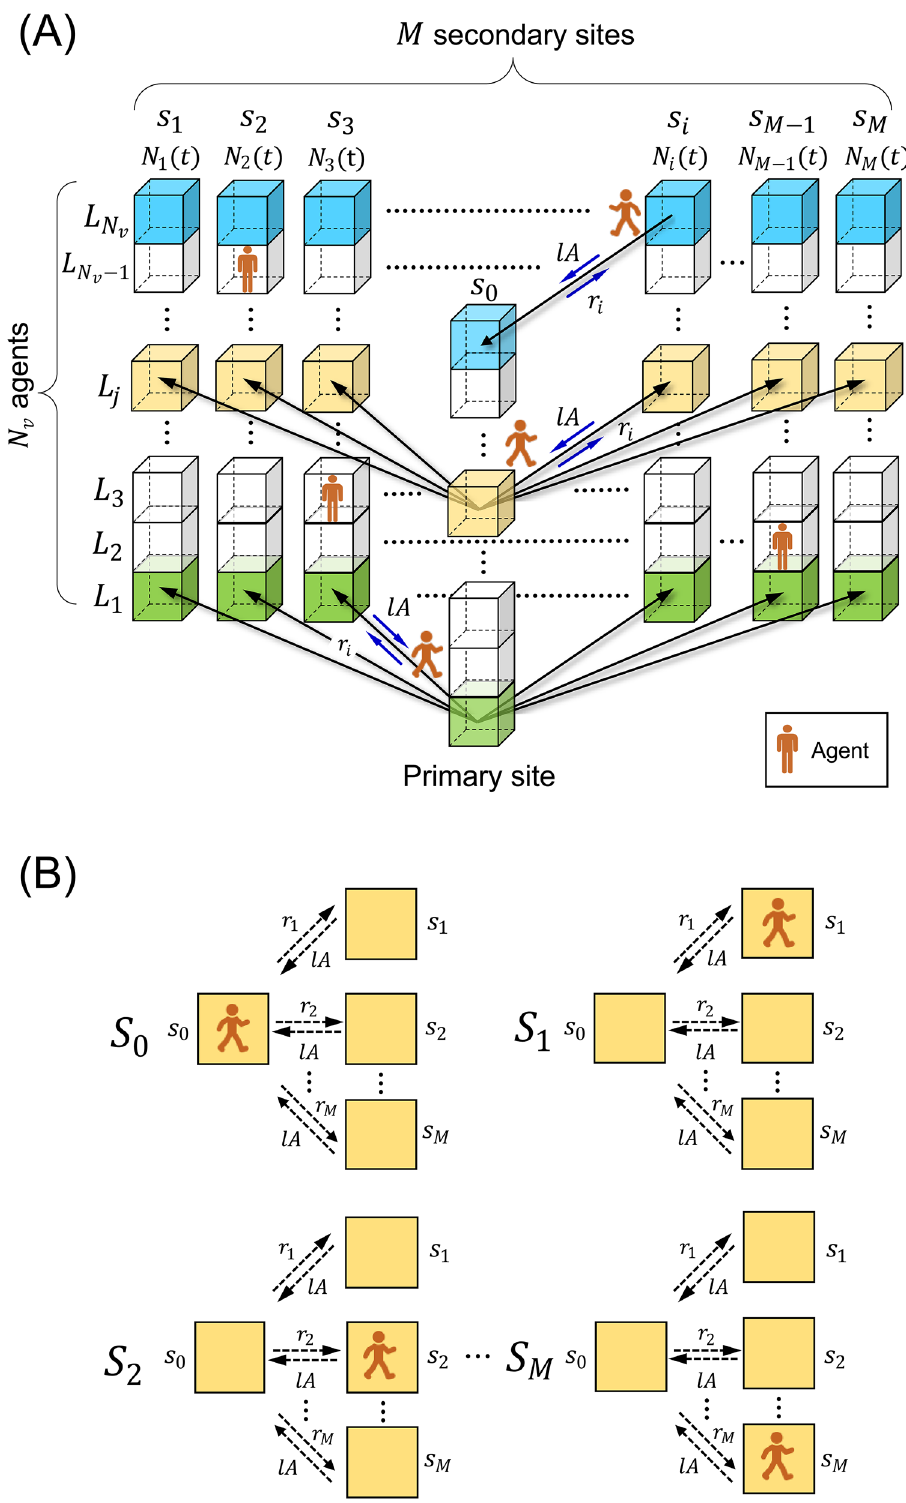
Figure 1. Schematic of the target